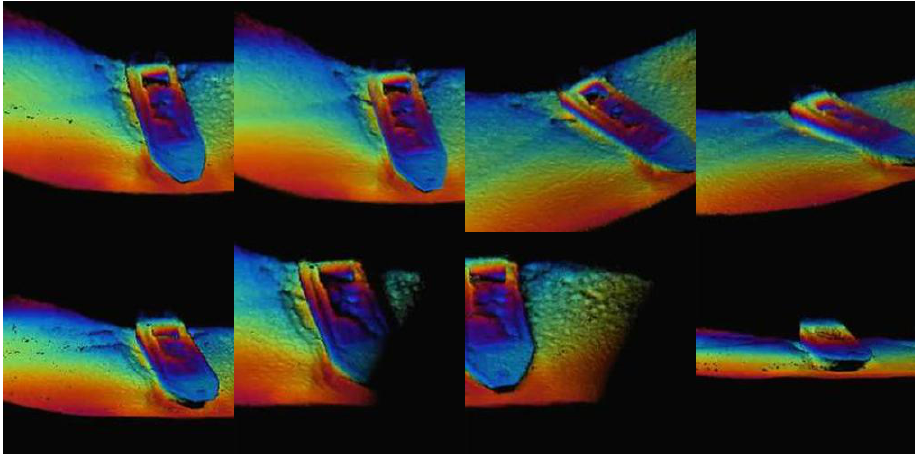
Figure 12. LN-P-GAN input